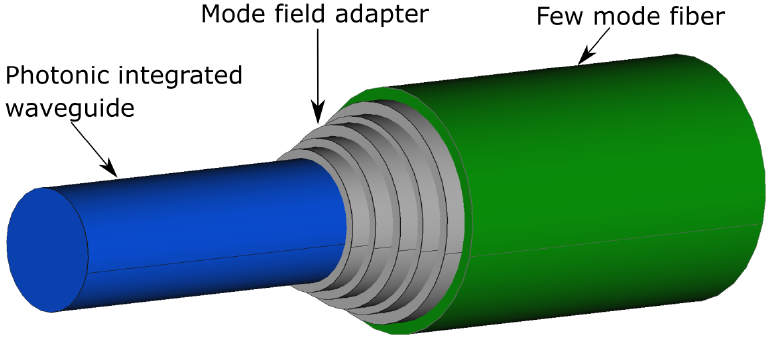
Figure 1. Mode field adapter—spot size converter